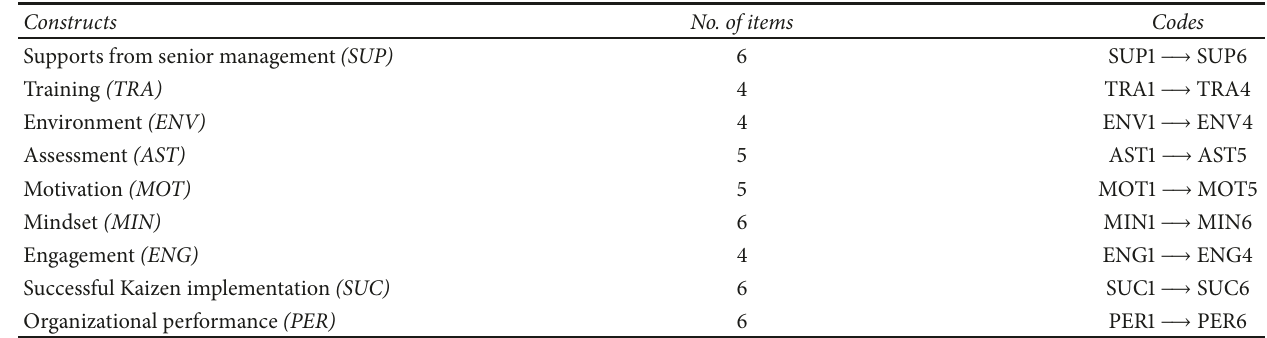
Table 2: Codes of investigated constructs and observed items.